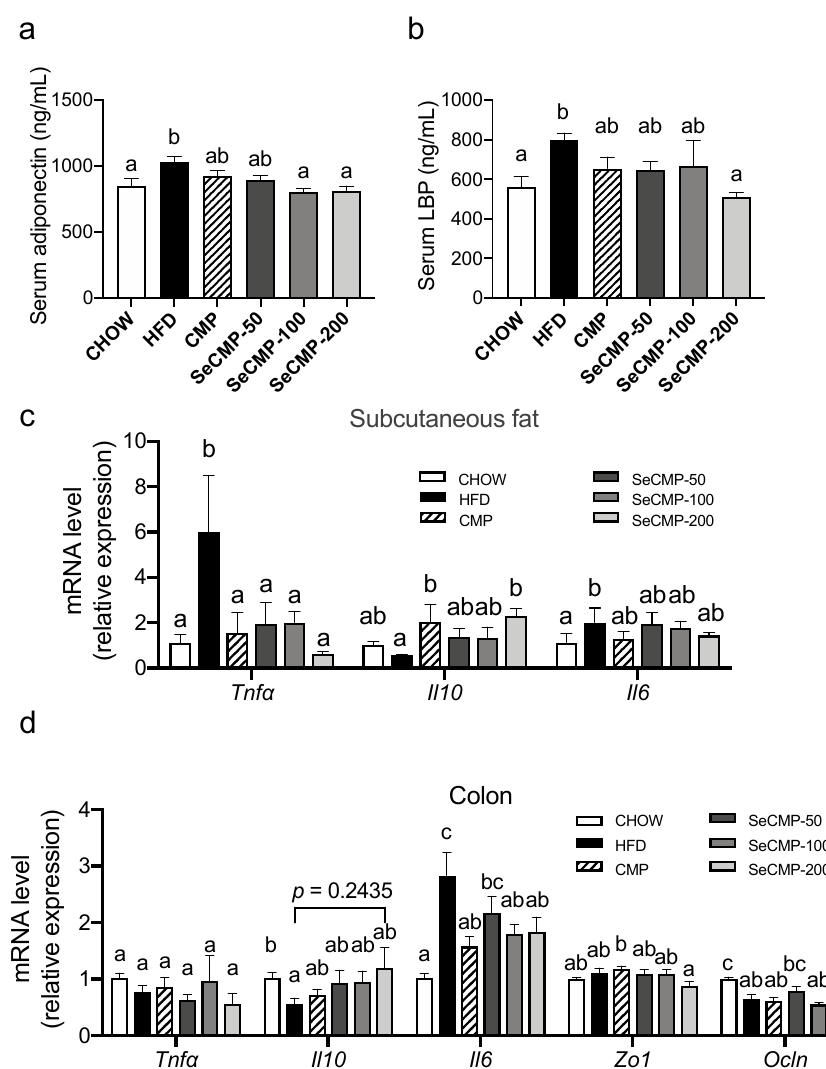
Figure 3. Administration of selenium-rich C. militaris crude polysaccharides (SeCMP) alleviated inflammation in C57BL/6J obese mice. ( a ) Serum lipopolysaccharide-binding protein (LBP); ( b ) adiponectin; ( c ) subcutaneous fat inflammation cytokine genes, including tumor necrosis factor-alpha (Tnf- α ), interleukin-10 (Il10), and interleukin-6 (Il6); ( d ) Colon inflammation cytokine gene expression, including Tnf- α , Il10, and Il6 and tight junction genes (Zonula occludens 1, Zo1 and Occludin, Ocln). Data represent mean ± SE (n = 6 mice/group). Superscript characters indicate significant variation among treatments in panel ( a , b ). In panel ( c , d ), superscript characters indicate significant variation among treatments of each gene. CHOW: normal diet + sterile water; HFD: high-fat diet + sterile water; CMP: high-fat diet + 100 mg/kg CMP; SeCMP-50: high-fat diet +50 mg/kg SeCMP; SeCMP-100: high-fat diet +100 mg/kg SeCMP; SeCMP-200: high-fat diet +200 mg/kg SeCMP.